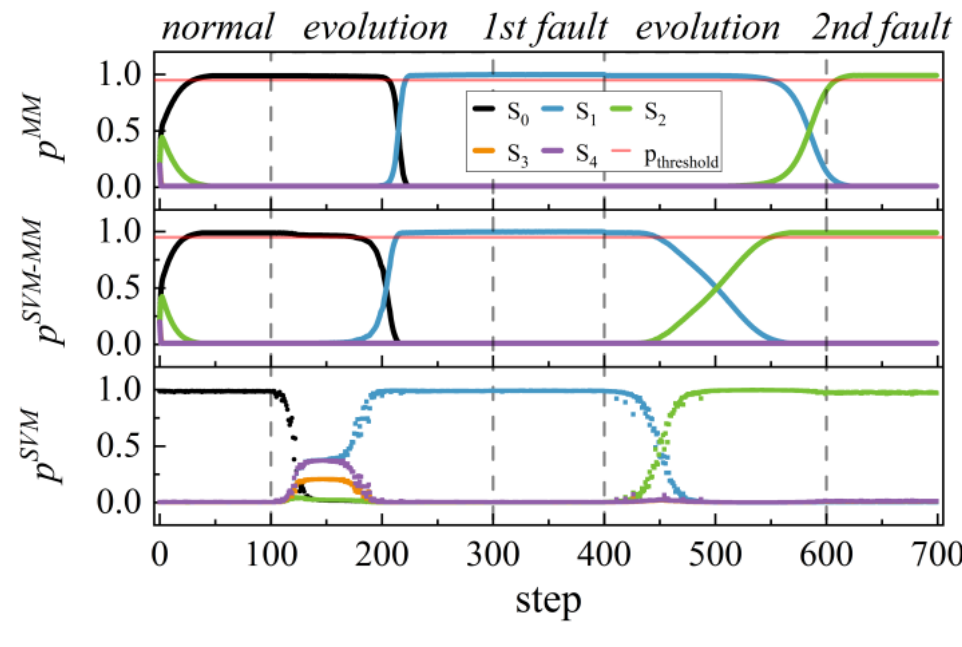
Figure 7. Diagnosis results for multiple faults: S 1 and S 2 .